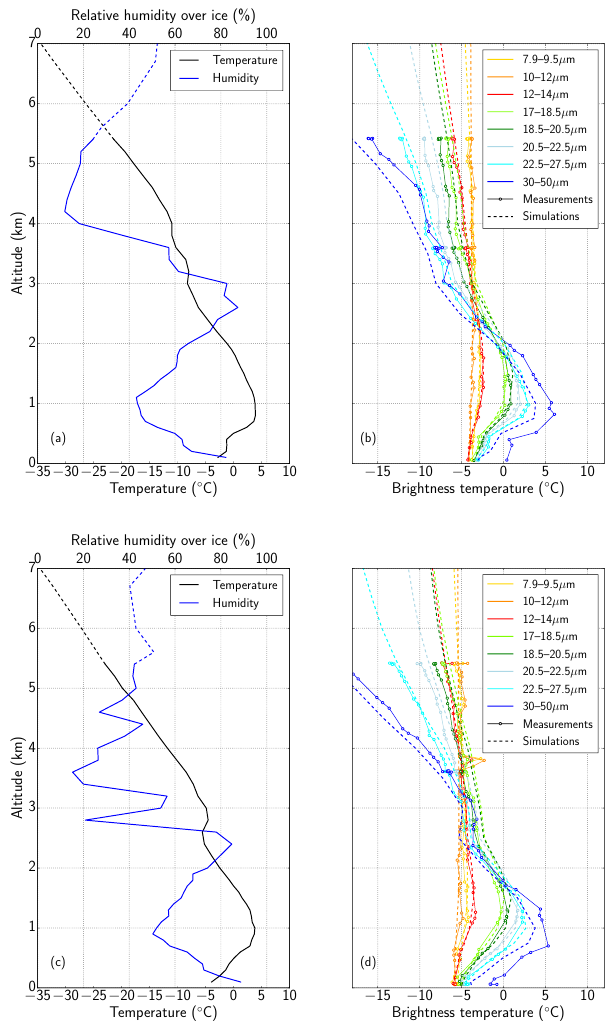
Figure 8. Vertical profiles of temperature and relative humidity for (a) 20 April and (c) 21 April flights. Measured and simulated FIRR brightness temperatures for (b) 20 April and (d) 21 April flights. The dashed lines in panels (a) and (c) correspond to the ERA- Interim profiles used for the simulations above maximum flying al-